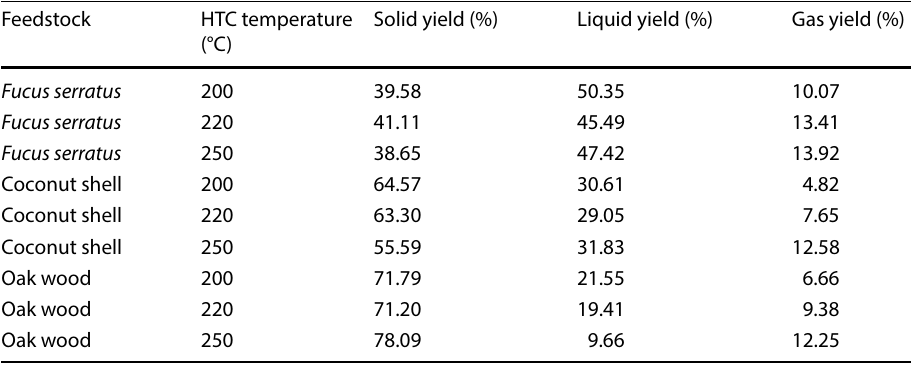
Gas yield = 100 – (hydrochar yield + liquid